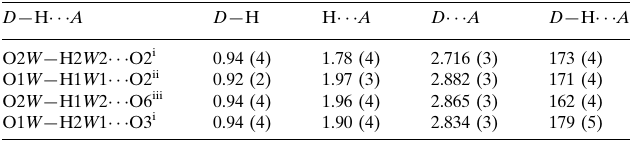
Hydrogen-bond geometry (A˚ , (cid:1)